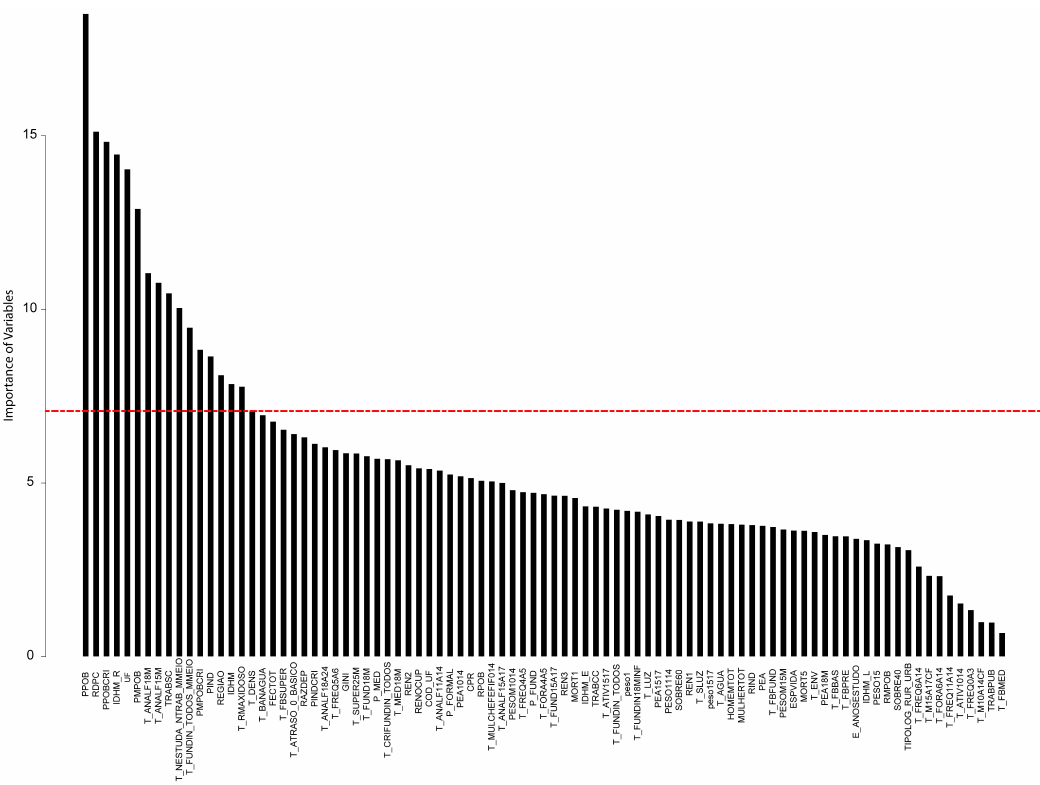
Figure 6. Importance of variables with cutoff point via CART regression modeling. Source: prepared by the authors.